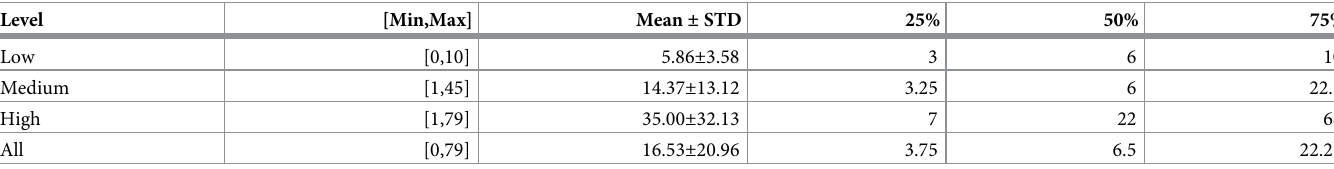
Descriptive summary statistics (minimum; maximum; mean; standard deviation; and first, second, and third quartiles) describing the error encountered in the subsets of images defined by complexity